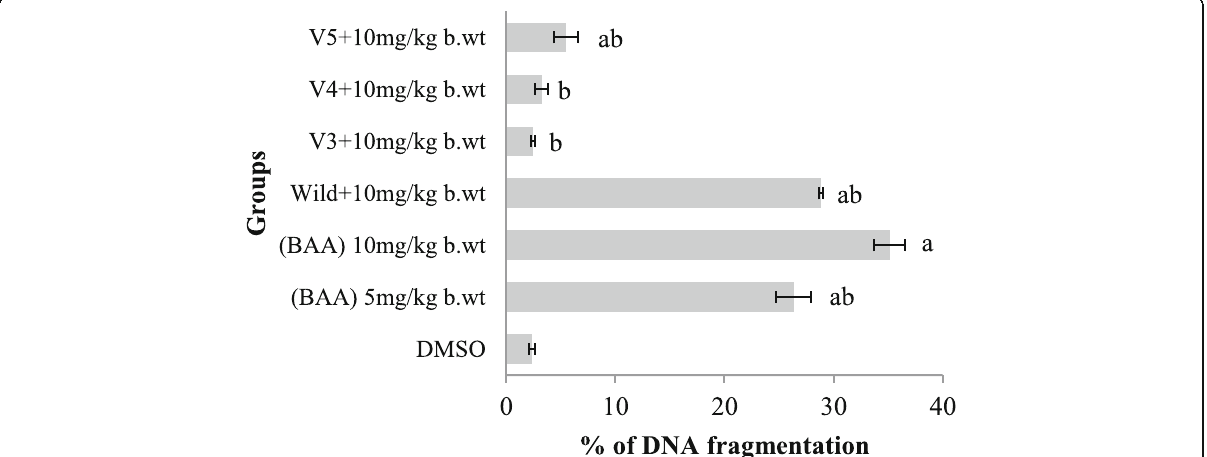
Fig. 2 The effect of (BAA) or its residues after biodegradation by different types of bacteria on the % of the DNA fragmentation. ( p <0.05), a: comparison with DMSO group, b: comparison with (BAA)10mg/kg bwt.